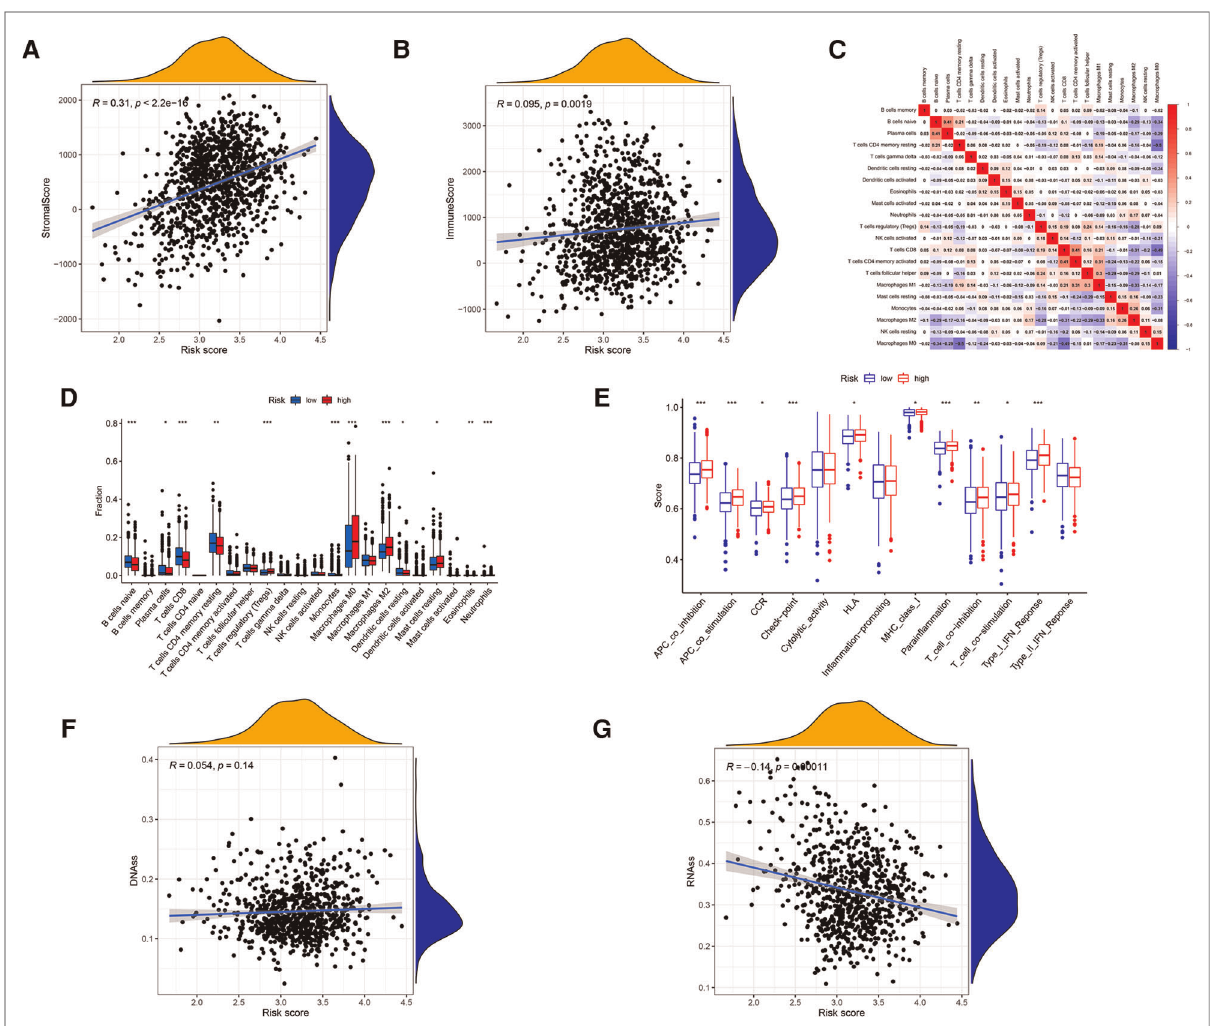
FIGURE 6 Analysis of the GRG signature in tumor microenvironment, including ( A ) stromal cells, ( B ) immune cells, ( C ) correlations among the immune cells, ( D ) 22 kinds of tumor-in fi ltrating immune cells, ( E ) 13 kinds of immune related function, ( F ) DNAss and ( G )